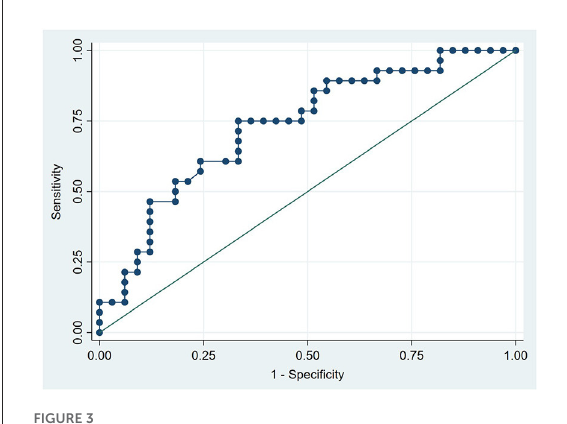
FIGURE5 The comparison of AUCs using Z test. The AUC of plasma PAGln level in predicting ISR was significantly higher than that of plasma phenylalanine level ( P =